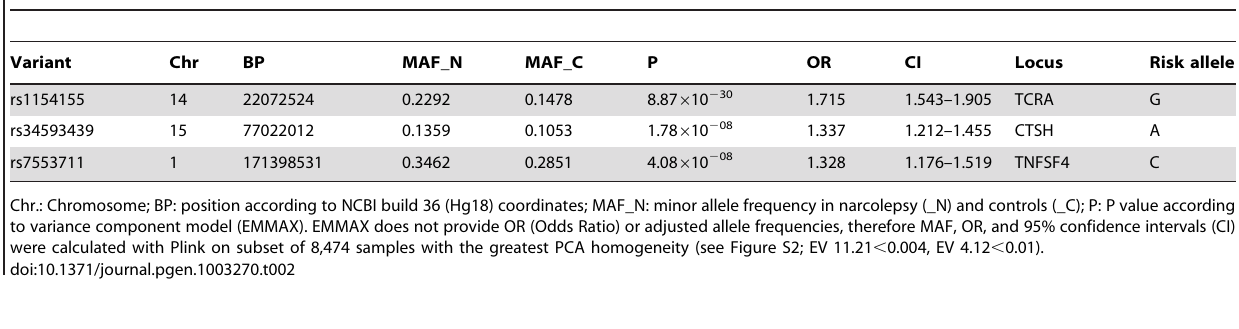
Table 2. Non-HLA narcolepsy risk variant loci reaching genome-wide significance.